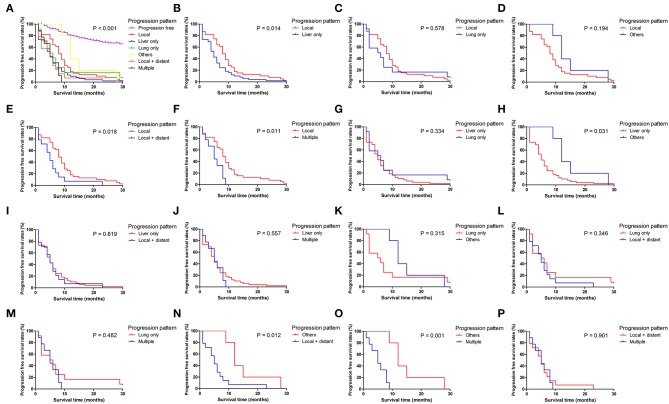
Pairwise comparison of progression-free survival for different tumor progression patterns. (A) Stratification of patients using different progression patterns of progression free, local, liver only, lung only, others, local and distant and multiple progressions. (B–P) Stratification of patients by comparing the following patterns of progression: local vs. liver only, local vs. lung only, local vs. others, local vs. local + distant, local vs. multiple, liver only vs. lung only, liver only vs. others, liver only vs. local + distant, liver only vs. multiple, lung only vs. others, lung only vs. local + distant, lung only vs. multiple, others vs. local + distant, others vs. multiple and local + distant vs. multiple.